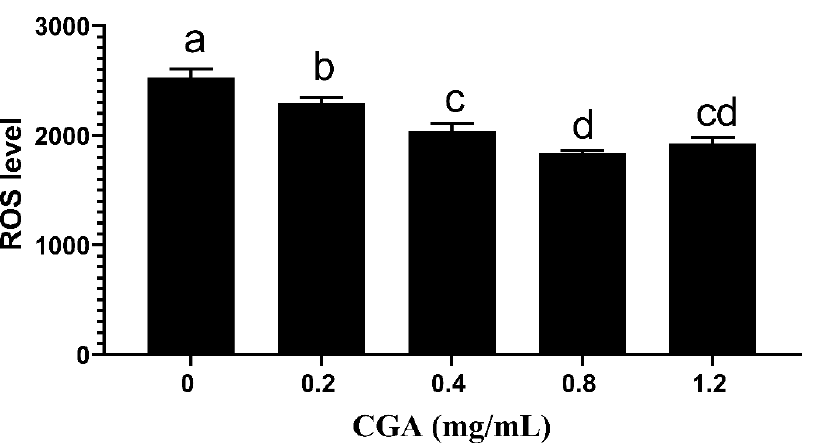
Figure 1. Effects of CGA with different concentrations on ROS level of chilled sperm on the fifth day. Note: Different letters above the column indicate significant difference, the same or containing the same letter indicate insignificant difference.